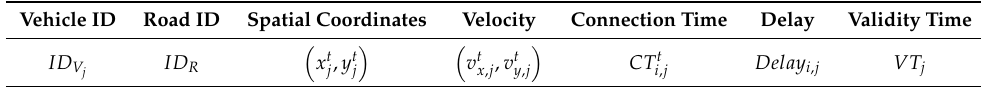
Table 2. Neighborhood table